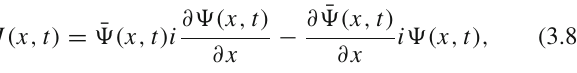
Fig. 1 Graph of the quaternionic potential well